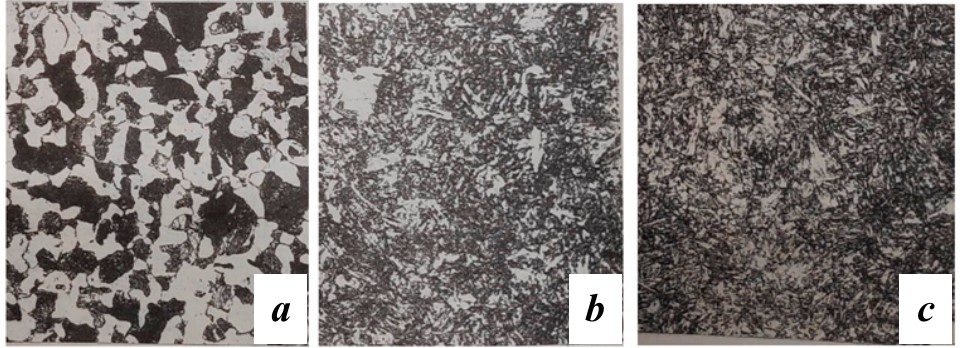
Figure 2. Microstructure of metal cylinders ( × 500) after storage of compressed hydrogen: ( a ) steel 45; ( b ) 38KhA; ( c ) 35KhN3MFA [41].